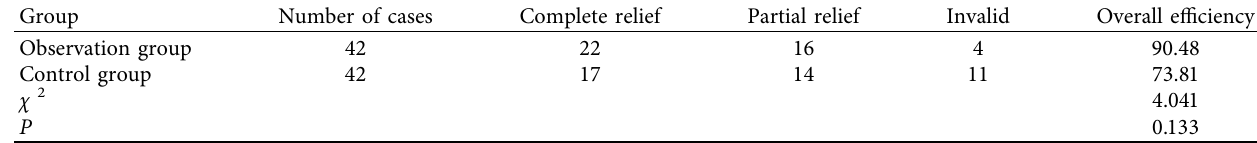
Table 1: Comparison of therapeutic efficacy between the two groups of patients ( n ,